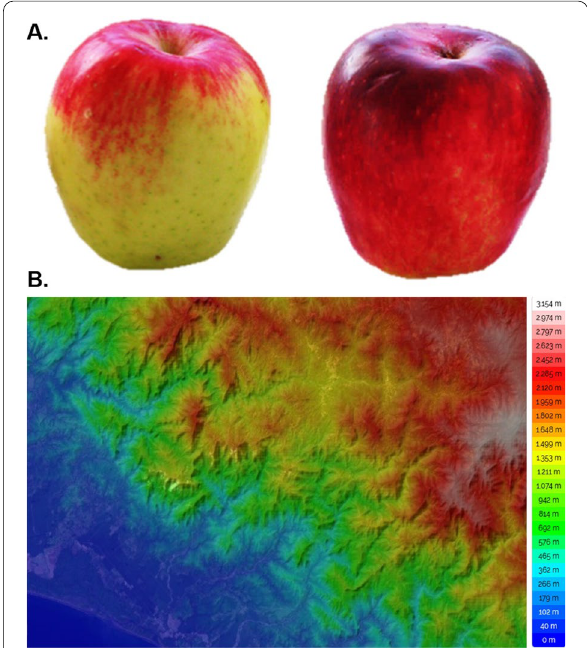
Fig. 1 A . Early ripe (left) and ripe (right) apple fruits ( Malus domestica cv. Anna) from San Marcos de Tarrazú, San José, Costa Rica (collected under permit R‑CM‑ITCR‑002–2021‑OT, CONAGEBIO, MINAE, Costa Rica). Locally grown fruits may be recognized by the green‑yellow spots on their peel, and their tangy acidic flavor. B . Topographic map of the Costa Rican region where the cultivars are grown, which locates at about 1500 m.a.s.l. Geographically, it is located between coordinates 83°58 ′ 16" to 84°9 ′ 28" west longitude, and 9°26 ′ 46" to 9°43 ′ 7" north latitude